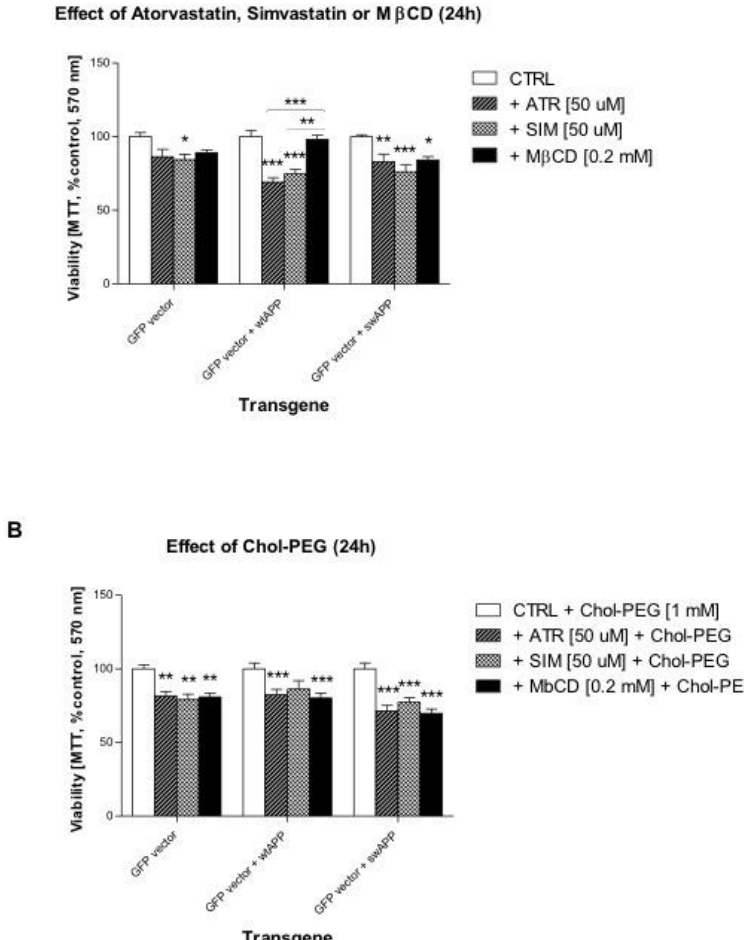
Figure 1. Effect of water-soluble cholesterol (Chol-PEG, 1 mM) on cell viability affected by mevalonate (MEV) pathway modulators (atorvastatin – ATR, simvastatin – SIM, 50 µ M each) or cholesterol chelator methyl- β -cyclodextrin (M β CD, 0.2 mM). One day (24 h) treatment with ( A ) ATR or SIM (50 µ M) or M β CD (0.2 mM) alone or ( B ) together with Chol-PEG. Bar charts show percentage (% control) cell viability measured by [3-(4,5-dimethylthiazol-2-yl)-2-5-diphenyltetrazolium